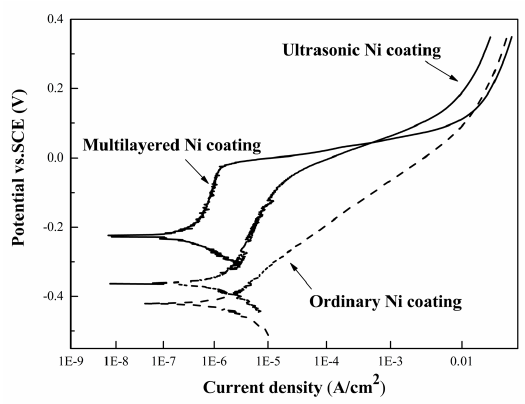
Figure 6. Potentiodynamic polarization curves for the Ni coatings in 3.5% NaCl solution at 298 K. Table 3. Corrosion parameters of the investigated coatings in 3.5% NaCl solution derived from potentiodynamic polarization curves. Type of coating